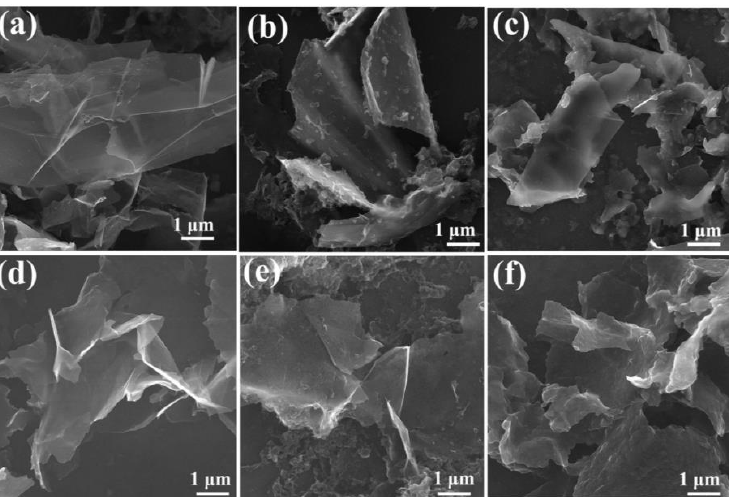
Figure 23. The effect of target material on the formation of GNS: ( a ) FG1 in acetone, ( b ) FG1 in water, ( c ) FG1 in DMF, ( d ) FG2 in acetone, ( e ) FG2 in water, ( f ) FG2 in DMF. Reprinted with permission from Ref. [89]. 2019, Elsevier.